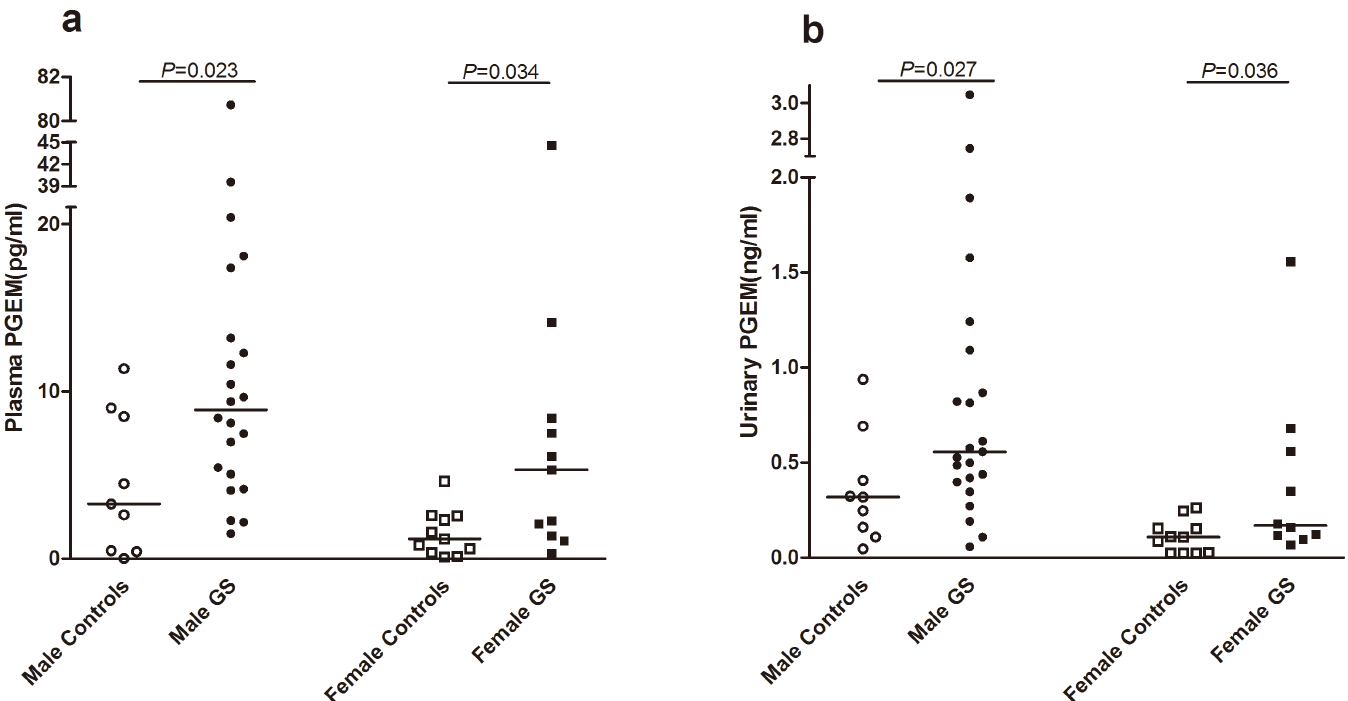
Fig 1. The median PGEM level in the plasma and urine samples of Gitelman syndrome patients. (a) The medianplasma PGEM level of GS patients and healthy controls. GS patients showed a higher medianplasma PGEM level than healthy controls of the same gender. ( b) The PGEM concentration of 24-h urine was higherin GS patients. Both male and female GS patients had a higher PGEM level than controls. The medianconcentration of plasma and urinaryPGEM in male individualswas higherthan that of females, both in GS patients and controls. Abbreviations: GS, Gitelman syndrome;PGEM, prostaglandin E2 metabolite.